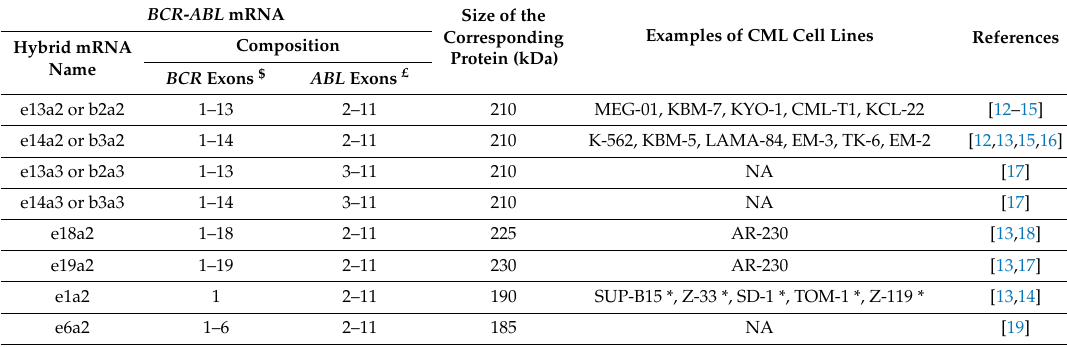
Table 1. Human BCR-ABL transcripts and proteins. The name and composition of the various human BCR-ABL hybrid transcripts identified in patients are described. The size of the corresponding proteins, their frequency of detection, and the cell lines expressing them are also indicated.